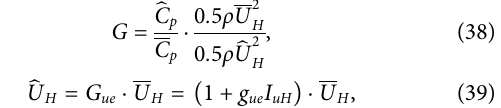
Frontiers in Built Environment |